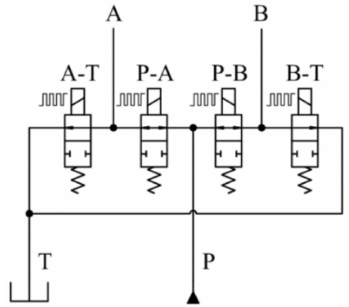
Figure 4. High-speed switching four-way valve.